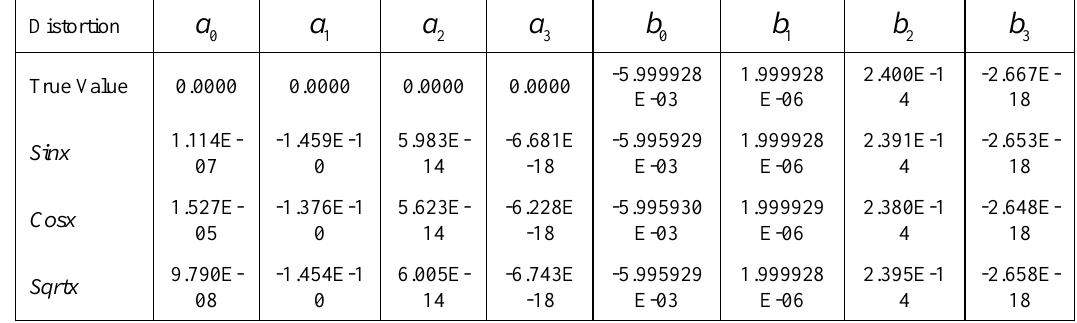
Table 3. Estimated internal parameters for different